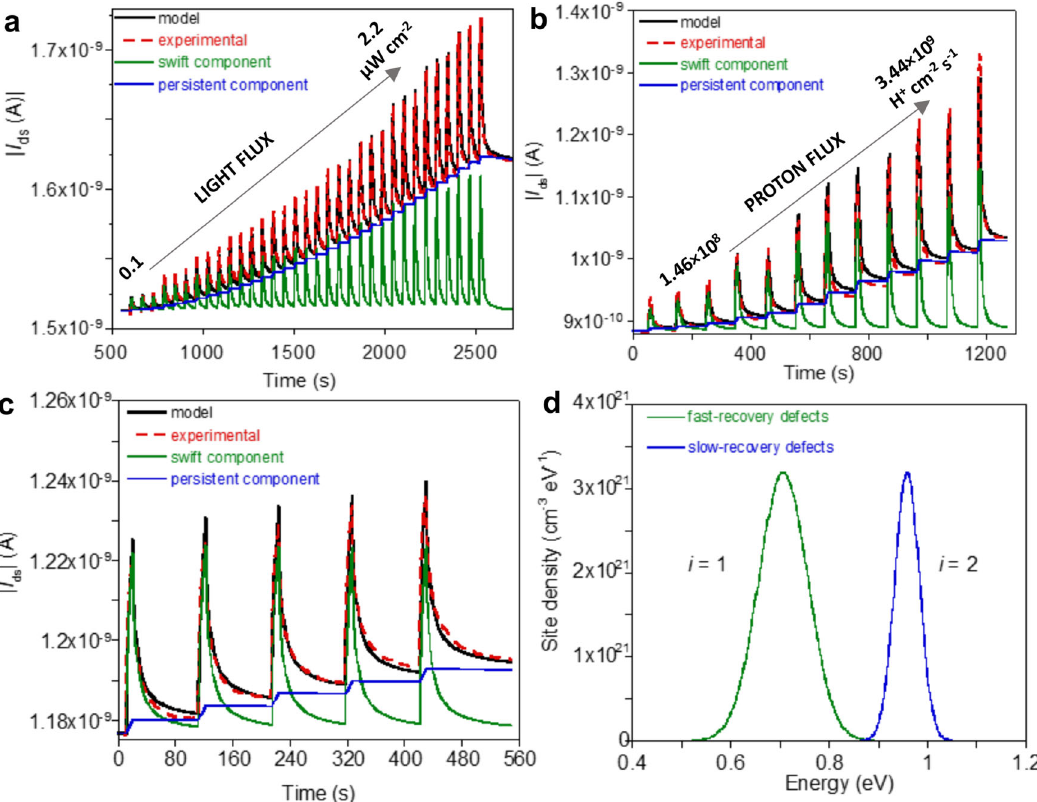
Fig. 5 Physical modeling of fully organic indirect proton detector. a Dynamic photocurrent measured (red line) and fi tted (black line) of an OPT under light exposure (light pulses 10 s long, fl ux ranging from 0.1 µW cm − 2 to 2.2 µW cm − 2 ); b fully integrated detector (PVP-MPS-based scintillator coupled to an OPT) under proton irradiation (beam pulses 10 s long and fl ux ranging from 1.46 × 10 8 H + cm − 2 s − 1 to 3.44 × 10 9 H + cm − 2 s − 1 ); c detector (PVP-MPS-based) under proton irradiation (repeated beam pulses 10 s long and fl ux equal to ( 7 ÷ 8) × 10 7 H + cm − 2 s − 1 ). In panels ( a – c ) are also shown the two components, swift (green lines) and persistent (blue lines), of the photocurrent. The increase of the current baseline in ( c ) is around 3.6 pA after each exposure. d Energy density distributions of sites that can host fast- (green line) or slow-recovery (blue line) (2) Dynamic photocurrent measurements under repeated exposures show a systematic drift due to the buildup of a persistent component of the photocurrent 54,55,68 . The resulting dark current increase is clearly noticeable in the measurements made on the OPT under light exposure (Fig. 5a) as well as in the measurements on the detector under proton irradiation (Fig. 5b, c). The persistent photocurrent component has a recovery time of the order of 10 5 s (more than one day in the dark), which is much longer than the characteristic time τ s of the swift component discussed above. It must be associated with defects with a distribution of activation energies with a mean value ε 2 considerably higher than ε 1 .